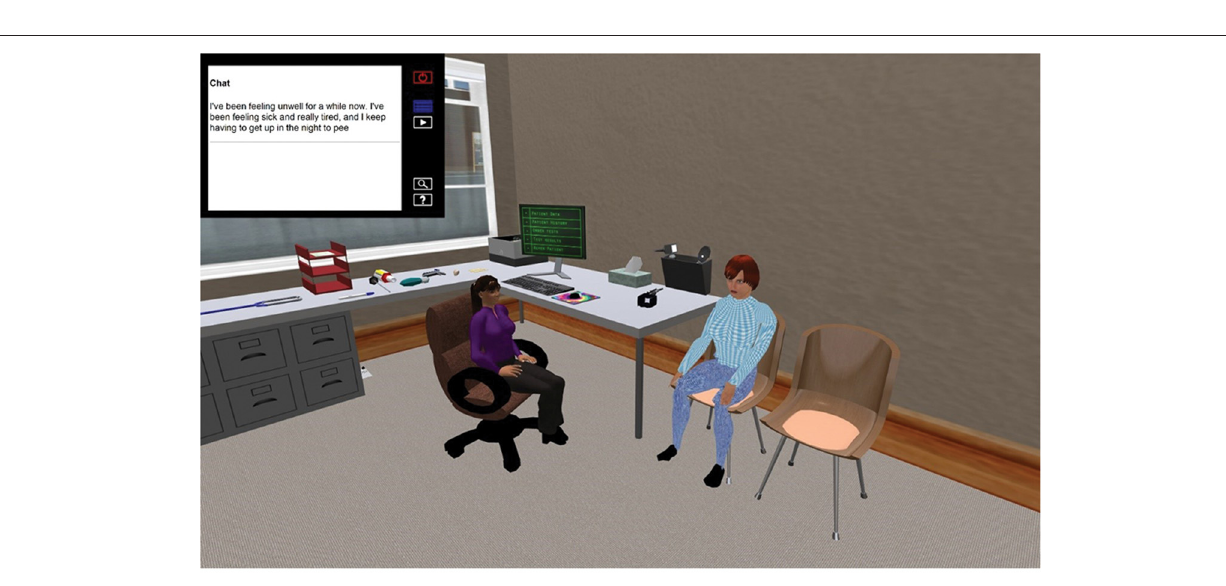
FIGURE 3 | The GP surgery, showing the HUD and chat information